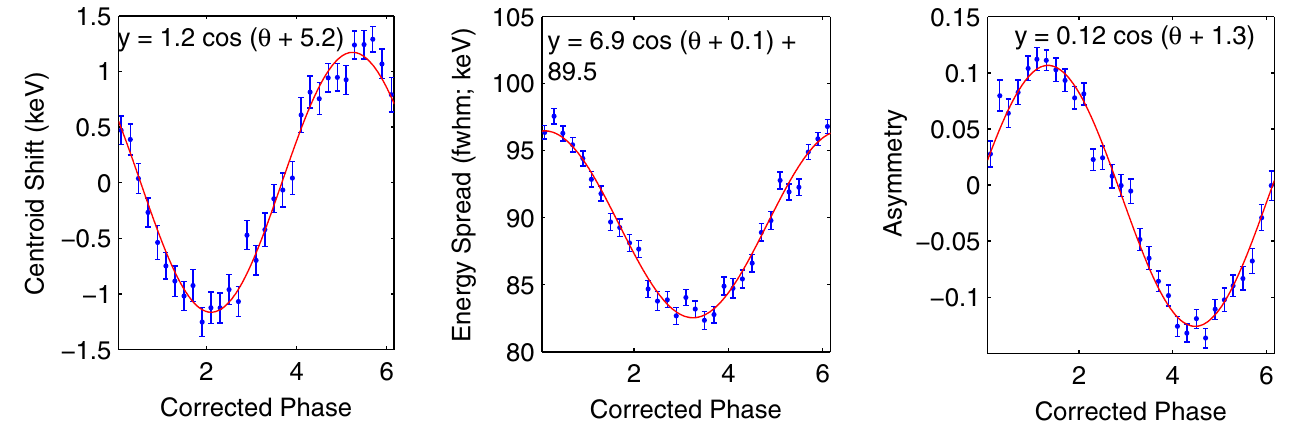
FIG. 6. (Color) Correlation of electron spectrum centroid energy (left), energy spread (center), and asymmetry (right) with the corrected phase subtracting slow drift. The error bars are the deviations of the means for the binned data. Also shown are sinusoidal fits to each